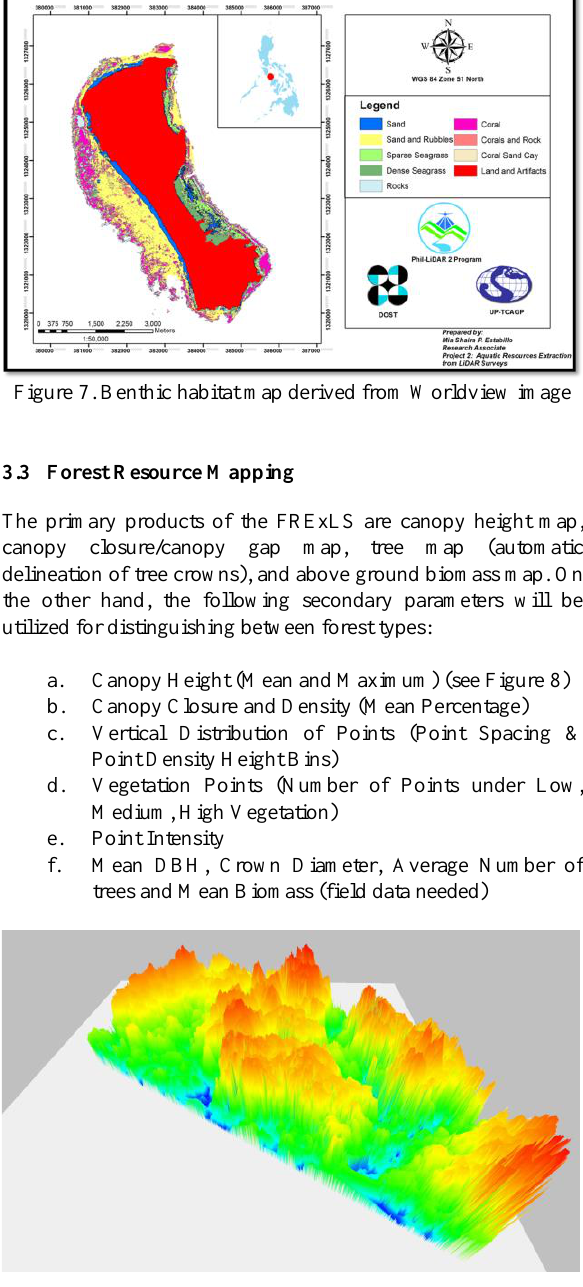
Figure 8. 3D view of the canoy height model of an area in Maipalig, Ilocos Norte, Philippines.